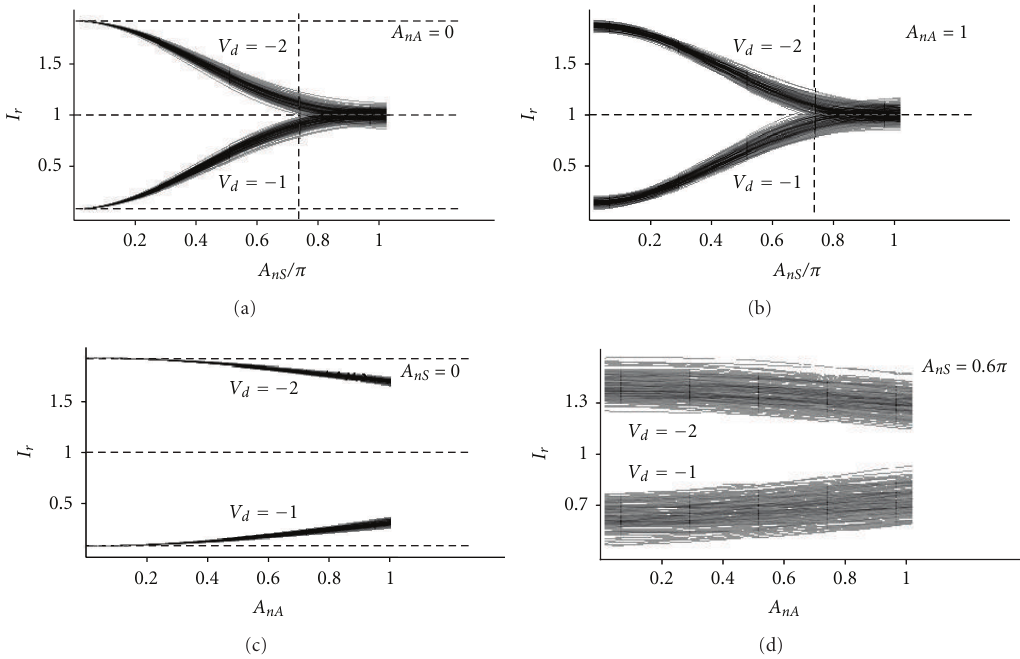
Figure 2: Influence of phase and amplitude noise with amplitudes A nS and A nA on the probability density of the intensity I r with Δ = 180 ◦ and ϕ = 0. The vertical dashed line corresponds to A nS = 0 . 72 π , while horizontal dashed lines correspond to relative intensity I r equal to 0, 1, and 2.